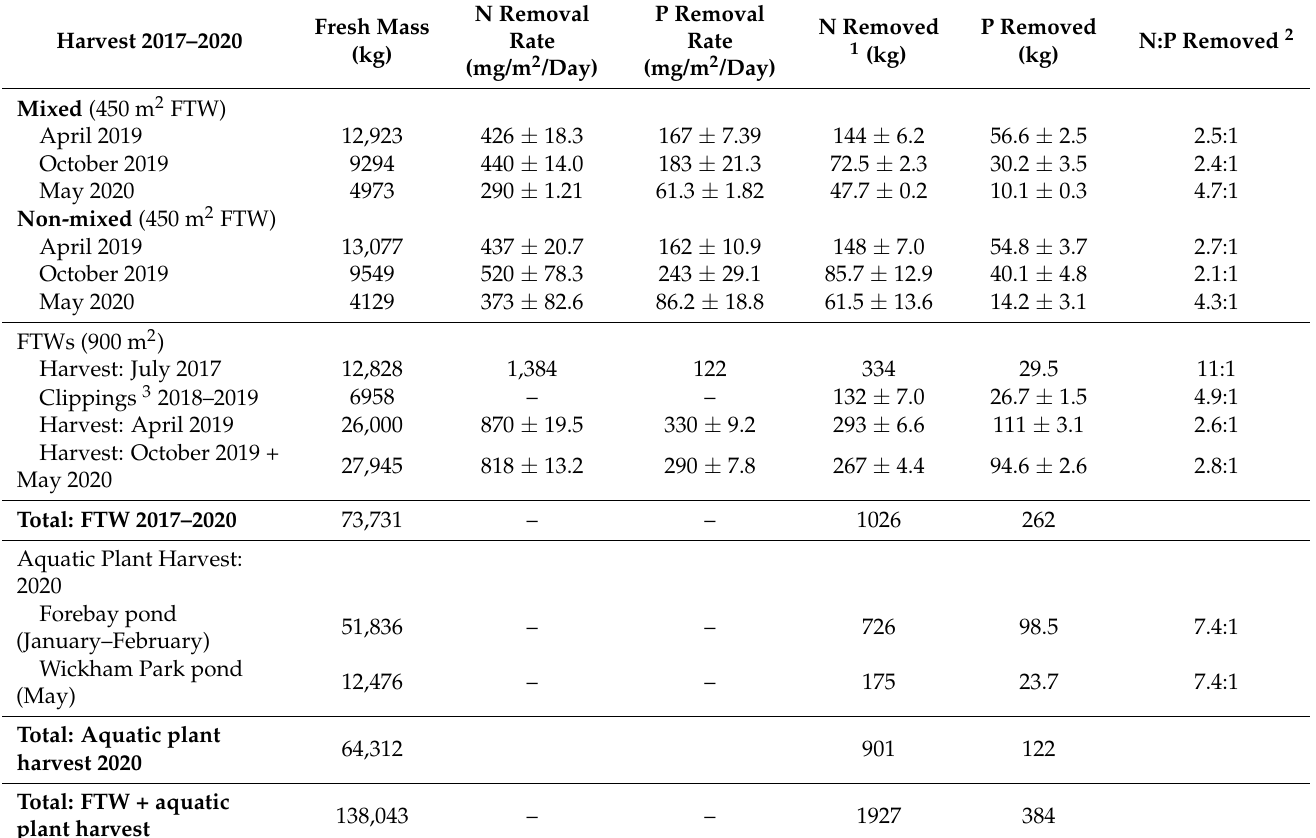
Table 4. Harvests (July 2017, April 2019, October 2019, May 2020) of whole plants from 900 m 2 floating treatment wetlands (FTW) deployed within the Wickham Park pond in Melbourne, FL, USA, and aquatic plants (2020) growing from the shoreline to the center of the forebay and Wickham Park Pond. Data presented include final fresh mass at harvest by treatment (mixed and non-mixed), daily rate of N and P removal per unit area of FTW, total nitrogen (N) and phosphorus (P) removed, and ratio of N:P within harvested